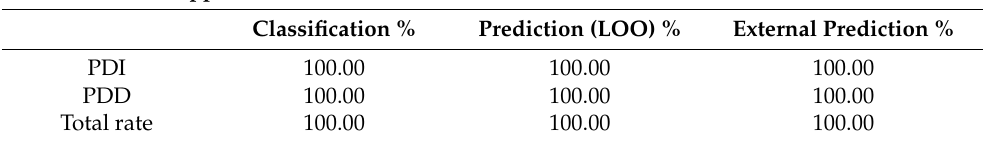
Table 3. Percentages of samples/patients classified correctly in both classification and internal/external validation in the SELECT-LDA performed when addressing the classification approach for PD stratification. 2-Class Approach SELECT-LDA: Parkinson’s Differentiation with 15 Variables Classification %